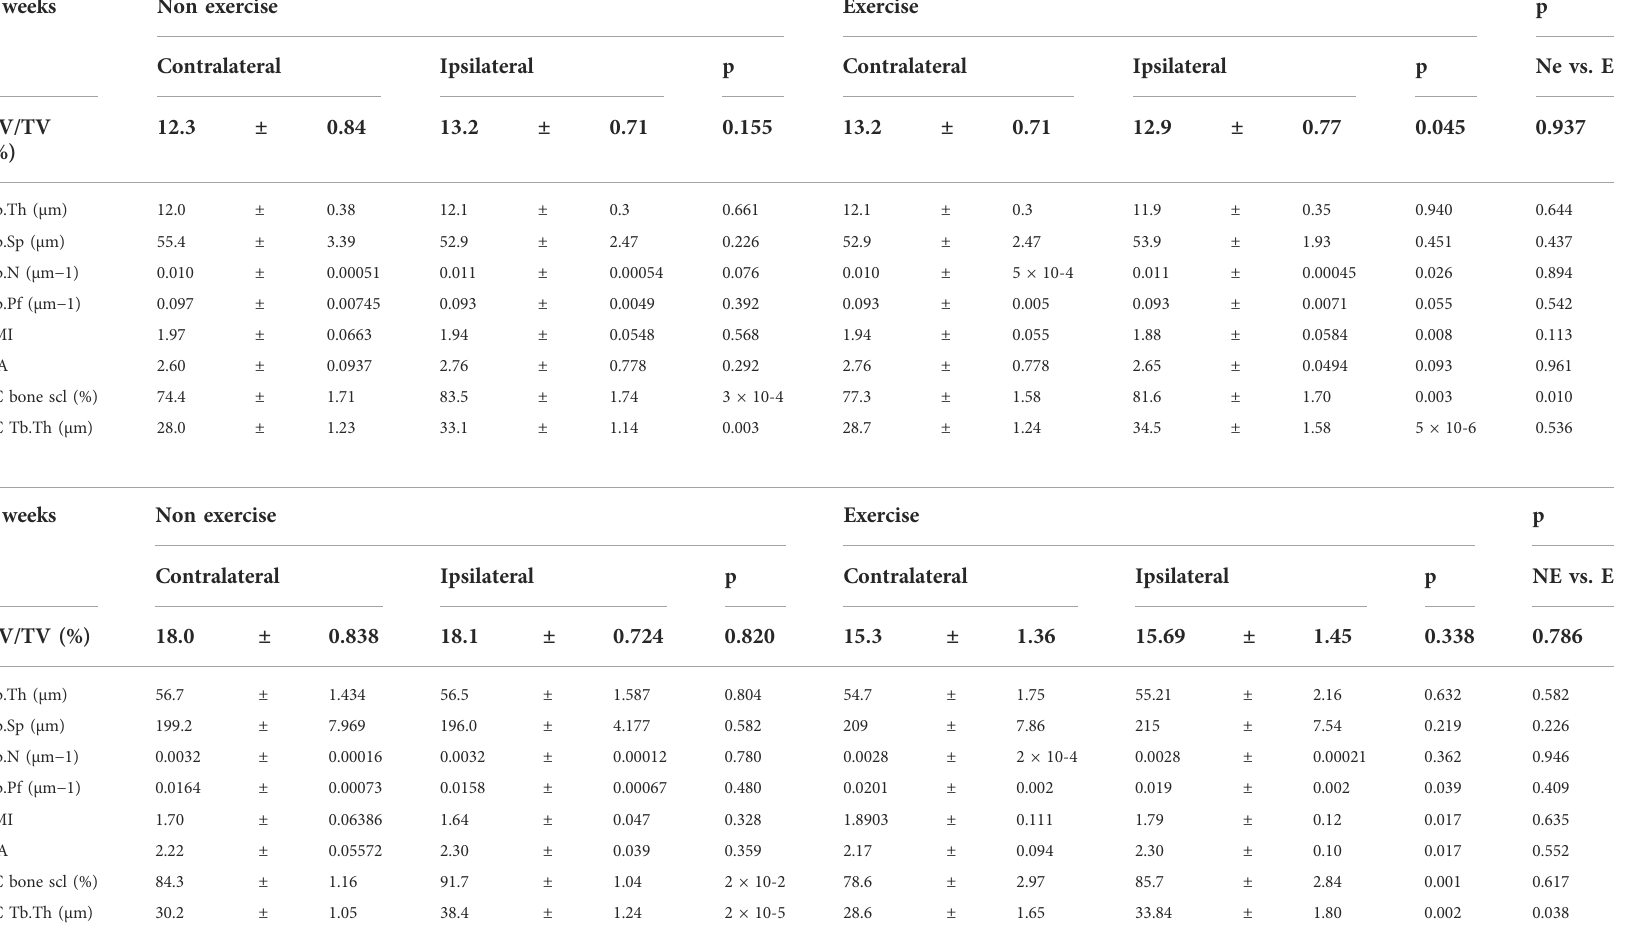
TABLE 2 MicroCT analysis of trabecular and subchondral bone changes in the DMM groups. BV/TV = Bone volume/Tissue volume. Tb.Th = trabecular thickness. Tb.No = Trabecular number. Tb.Sp. = Trabecular space. Tb.Pf = Trabecular pattern factor (connectivity). SMI = Structural model index (shape). DA = Degree of anisotropy (organization). SC = Subchondral. Bone scl = bone osteosclerosis. Each time point was analyzed with a Two-Way ANOVA, comparing relative changes to the contralateral leg and also interrogating the effect of exercise. Data was also compared between exercise and non-exercise within the DMM joint normalized against the contralateral leg (NE vs. E). p values under 0.05 were considered signi fi cant. 4 weeks Non exercise Exercise